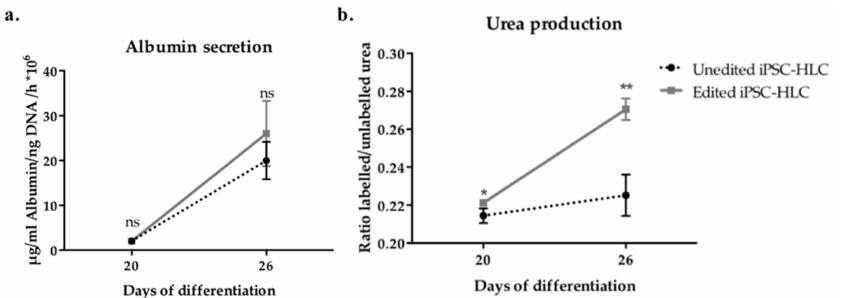
Figure 6. Albumin secretion and 15 N incorporation into urea. ( a ) Albumin secreted by unedited and edited iPSC hepatocyte-like cell (iPSC-HLC) was measured at days 20 and 26 of hepatic differentiation. Averages and errors are shown as means and standard deviation. Mann–Whitney U test was used for statistical analysis. Biological replicates n = 3. Ns: Not significant. ( b ) Incorporation of labelled 15 N into urea, which indicates the urea produced through the urea cycle, by unedited and edited iPSC- HLC, was quantified with mass spectrometry at days 20 and 26 of hepatic differentiation. Biological replicates n = 6. Mann–Whitney U test was used for statistical analyses. Ns: Not significant, p > 0.05, *: p ≤ 0.05, **: p ≤